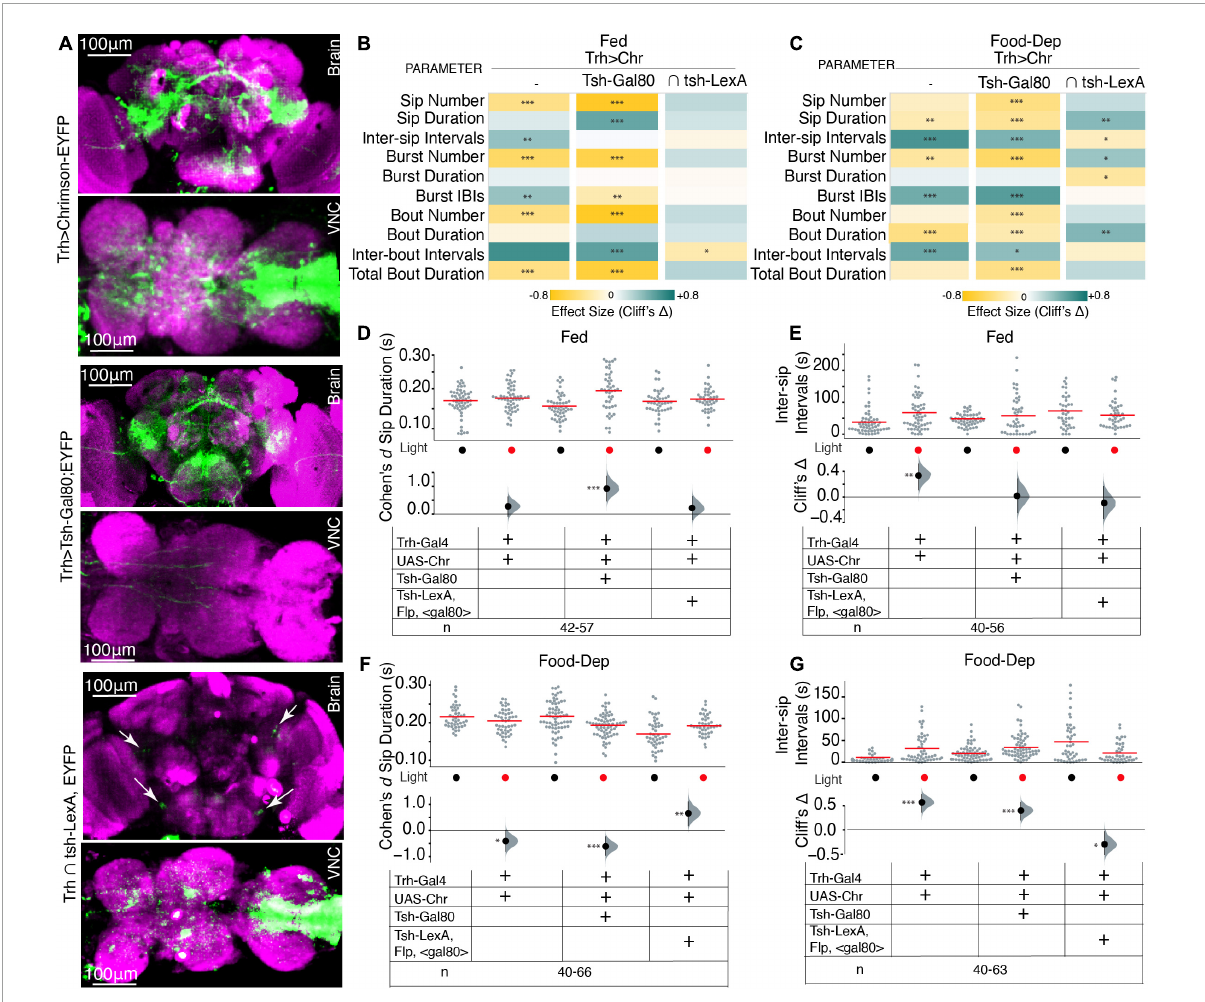
FIGURE3 Serotonin in the brain and VNC modulates feeding microstructure in a state-dependant manner. (A) Maximum intensity projections of expression patterns of serotonergic neurons in both brain and VNC labeled by Trh-Gal4 > UAS-Chrimson-YFP (upper), the brain only labeled by Trh-Gal4 ∩ tsh-Gal80;UAS-Chrimson-YFP (middle) and VNC only in Trh ∩ tub > gal80 > tsh-LexA,LexAop-Flp;Chrimson-YFP (lower); all immunostained with anti-dlg antibody. The scale bar is 100 um. White arrows in lower panels indicate positions of serotonergic PLP and SEL neurons. (B) Heat map showing Cliff’s (cid:49) effect sizes for all the parameters measured by the OptoPAD system for Trh > Chrimson,Trh ∩ tsh-gal80;Chrimson, and Trh ∩ tub > gal80 > ; tsh-LexA,LexAop-Flp;Chrimson for the fed state. (C) Heat map showing Cliff’s (cid:49) effect size for all the parameters measured by the OptoPAD system for Trh > Chrimson, Trh ∩ tsh-gal80;Chrimson, and Trh ∩ tub > gal80 > ; tsh-LexA,LexAop-Flp;Chrimson for the food-deprived state. (D) Cumming estimation plot showing the Cohen’s d for